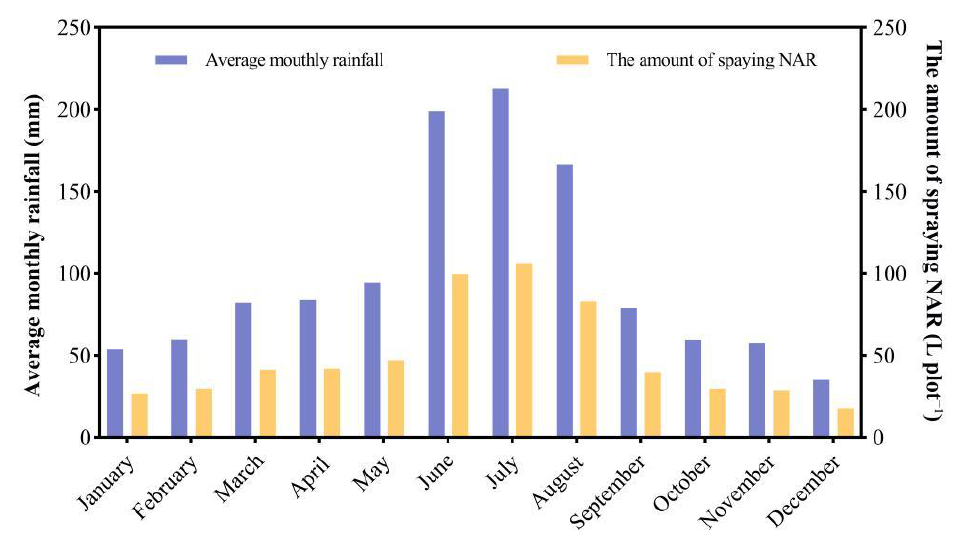
Figure 1. Average monthly rainfall and spraying amounts of NAR at the test plots. 2/3 of the average monthly rainfall from 2011 to 2021 was established as the total annual spraying amount per square meter, and 1/12 was taken as the monthly spraying amount per square meter. The amount of spraying at a given plot was calculated by the monthly spraying amount × 9 m 2 (the area of a single plot).